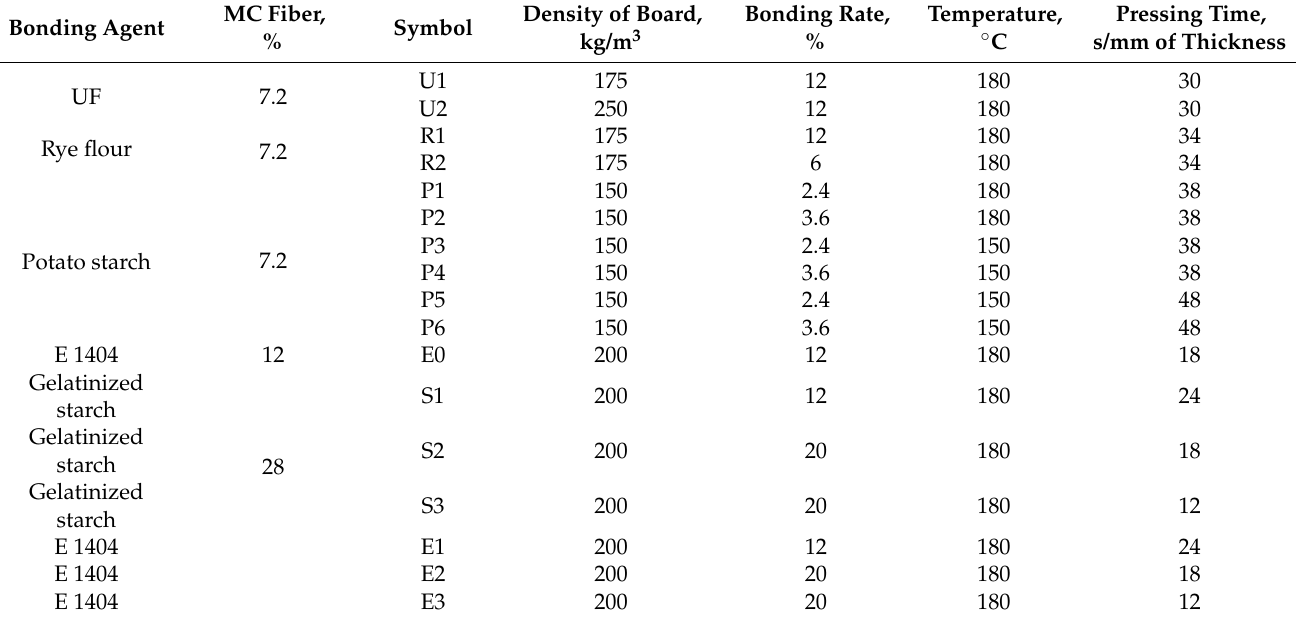
Table 1. Pressing variants